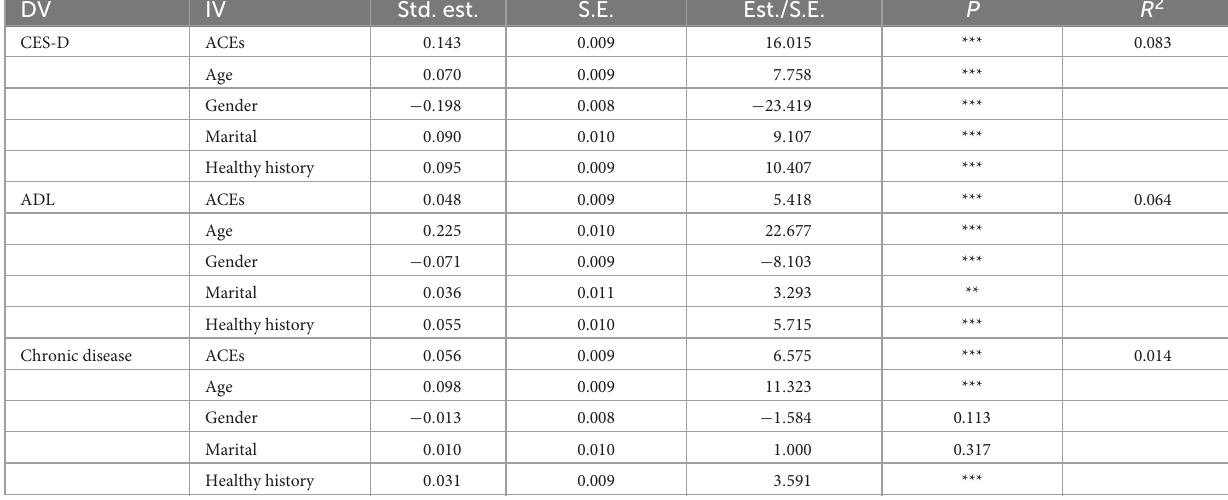
TABLE 4 Direct model regression weight.